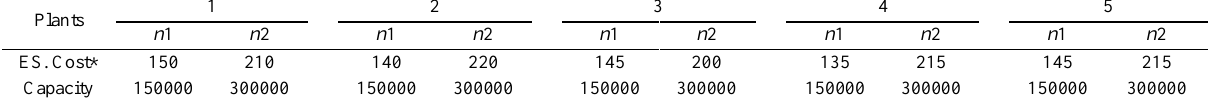
Table 6. Establishment cost and capacity of plants